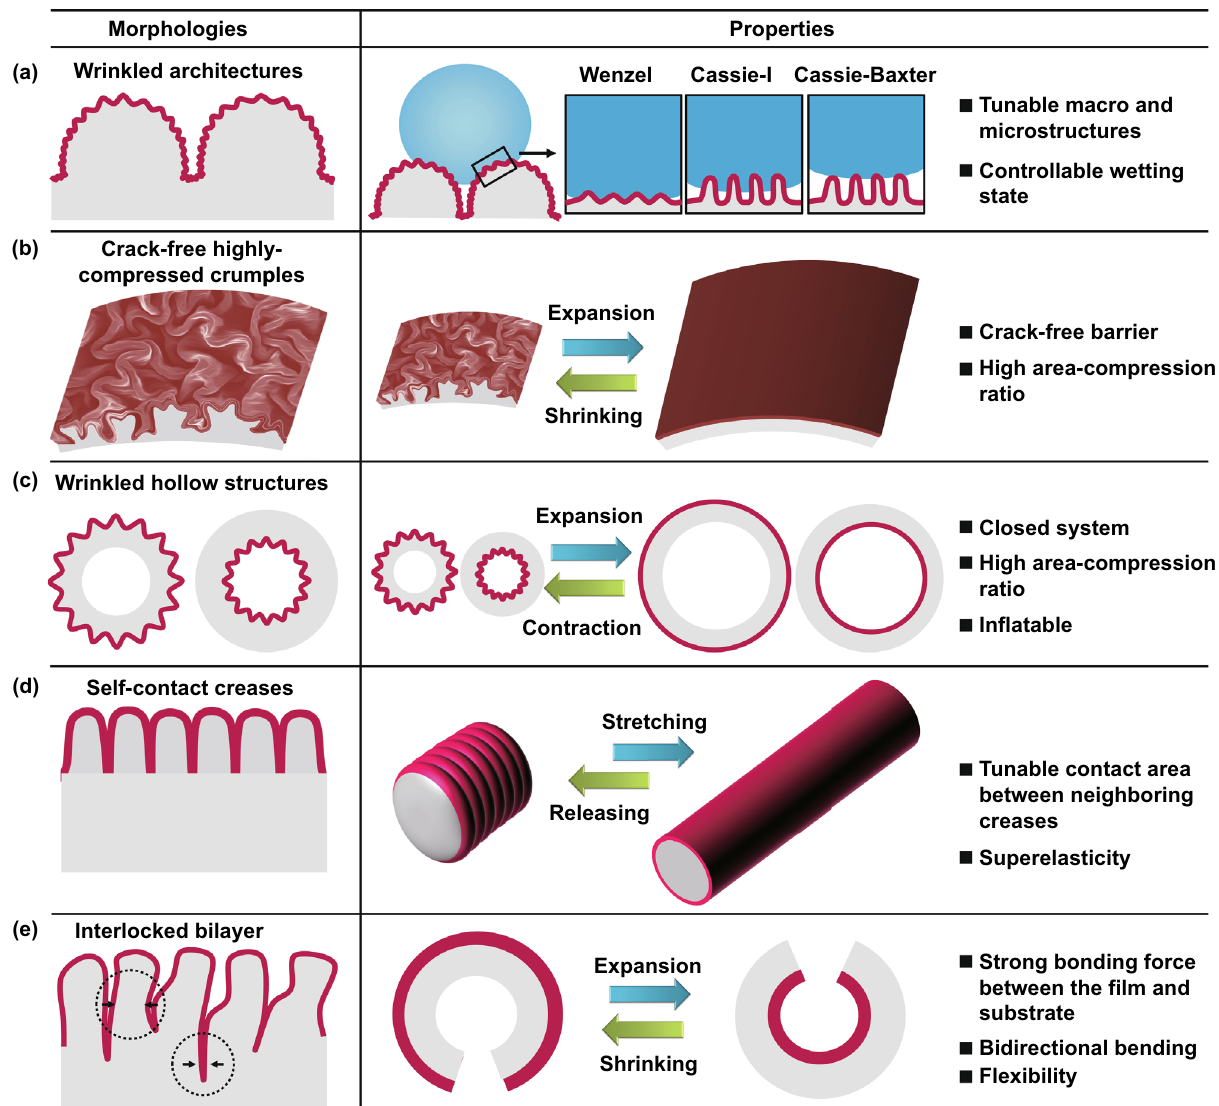
Fig. 13 Superior properties of various wrinkled structures on curved substrates. a Wrinkling patterns can be generated on diverse microarchi- tectures with various geometries. b Crack-free highly compressed films can be obtained by simultaneous global deformations on curved sub- strates. c For closed hollow structures, wrinkle-to-smooth transition can be induced by reversible expansion and contraction. d Self-contact creases can be achieved on superelastic cylindrical fibers, where the contact area between neighboring creases can be tuned linearly by external strain. e Formation of highly convoluted interlocked structures that is capable of enhancing the bonding force between the film and the curved